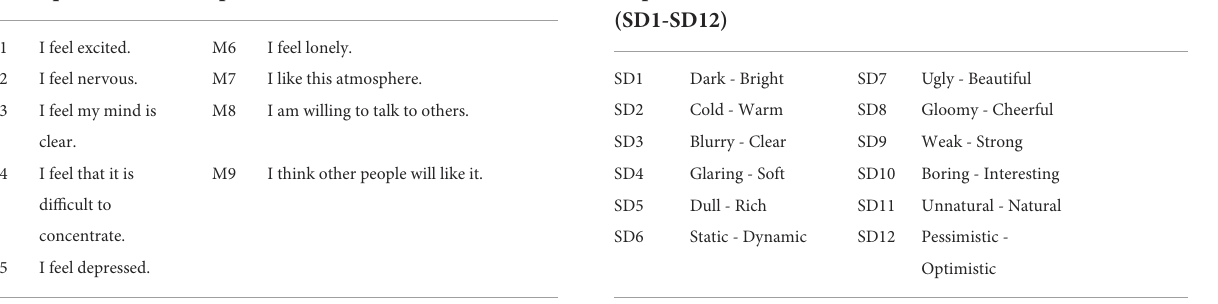
TABLE 2 Multiple Mood States